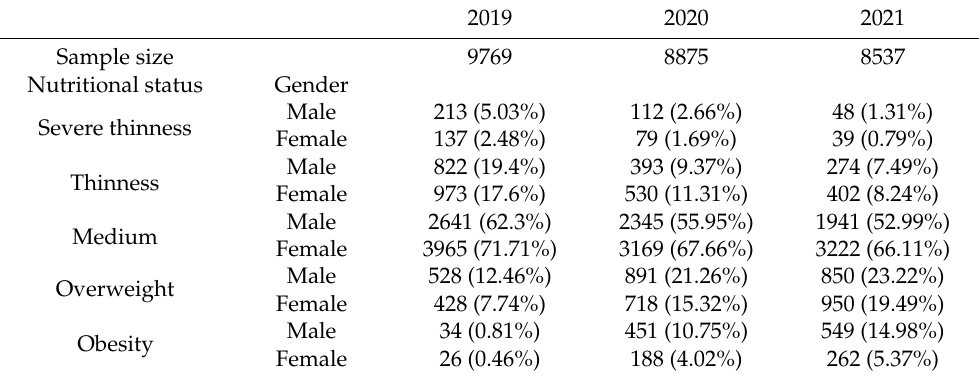
Table 3. The nutritional status of Chinese children and adolescents aged 7–22 years old in the CNSSCH, from 2019 to 2021.